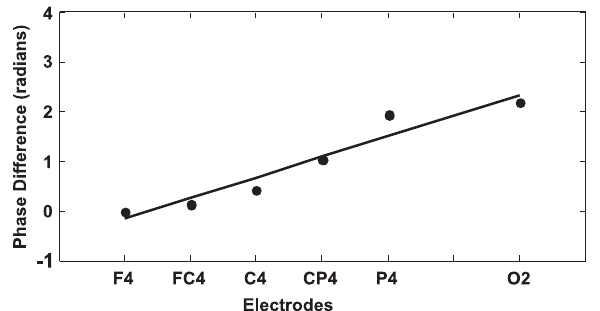
Figure 2. An illustration of gradual phase shift along the chain of electrodes from F4 to O2 for one typical subject. The dots for phase difference values and the solid line for a linear fit to them.